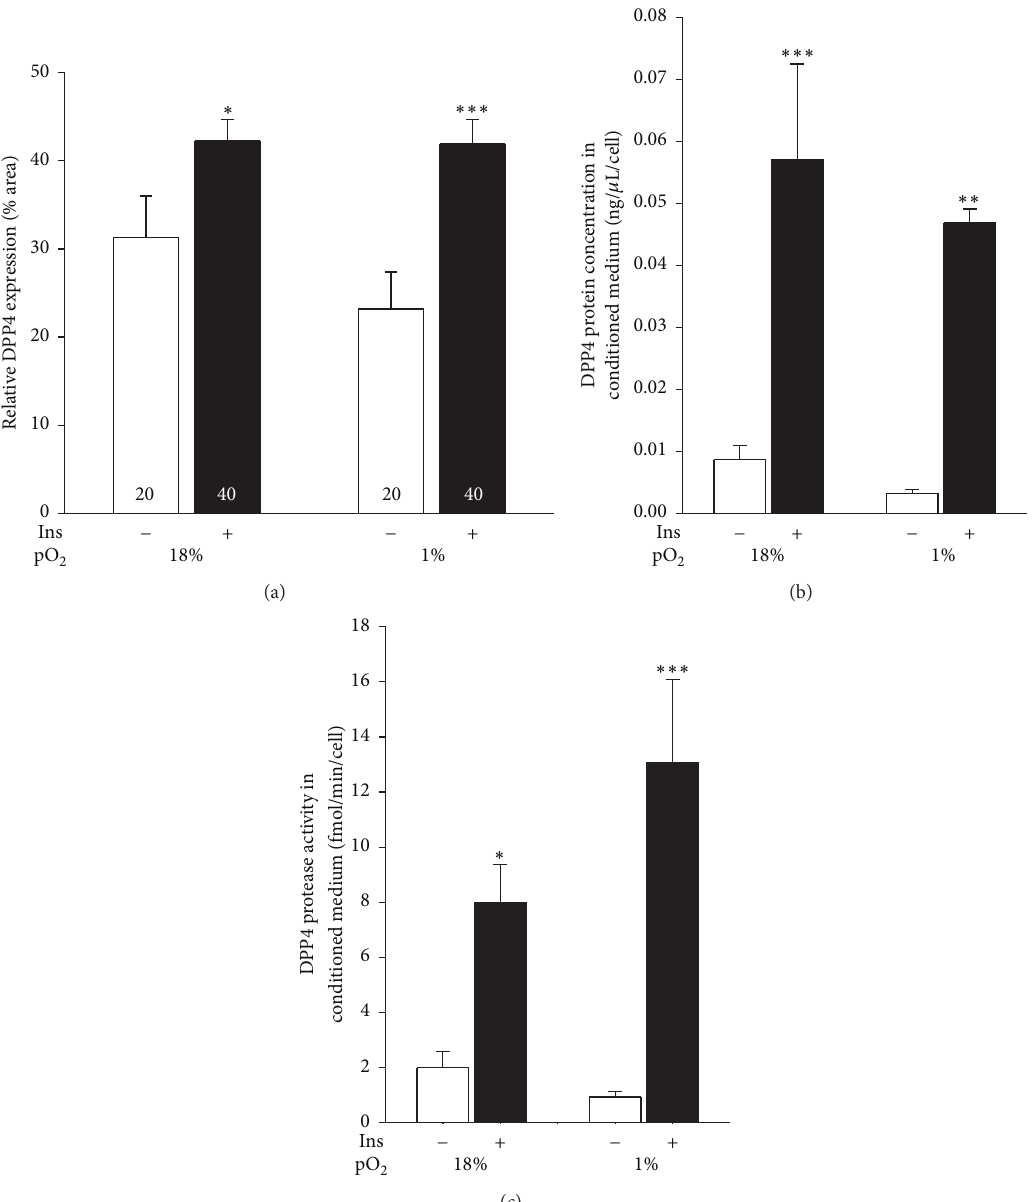
Figure 5: The effect of insulin on DPP4 expression and activity in human preadipocytes. (a) Human preadipocytes cultured for 2 days under normoxic(18%pO 2 )andhypoxic(1%pO 2 )conditionsweretreatedfor30 minwith100 nMinsulin(blackbars).Controlcellsweretreatedwith vehicle only for 30 min (white bars). Subsequently, the cells were immunolabeled with an antibody against DPP4 and imaged on a confocal microscope. The expression density of immunolabeled DPP4 was analyzed. Data are presented as means ± SE. Numbers denote the number of cells analyzed. The conditioned media were collected from cells treated for 30 min with insulin (Ins) and the protein concentration (b) and protease activity (c) of DPP4 were analyzed. Data are normalized to the number of cells in the sample and presented as means ± SE. Asterisks denote statistically significant differences compared with controls treated with vehicle only, as denoted ( ∗ 𝑃 < 0.05 ; ∗∗ 𝑃 < 0.01 ; ∗∗∗ 𝑃 < 0.001 ;